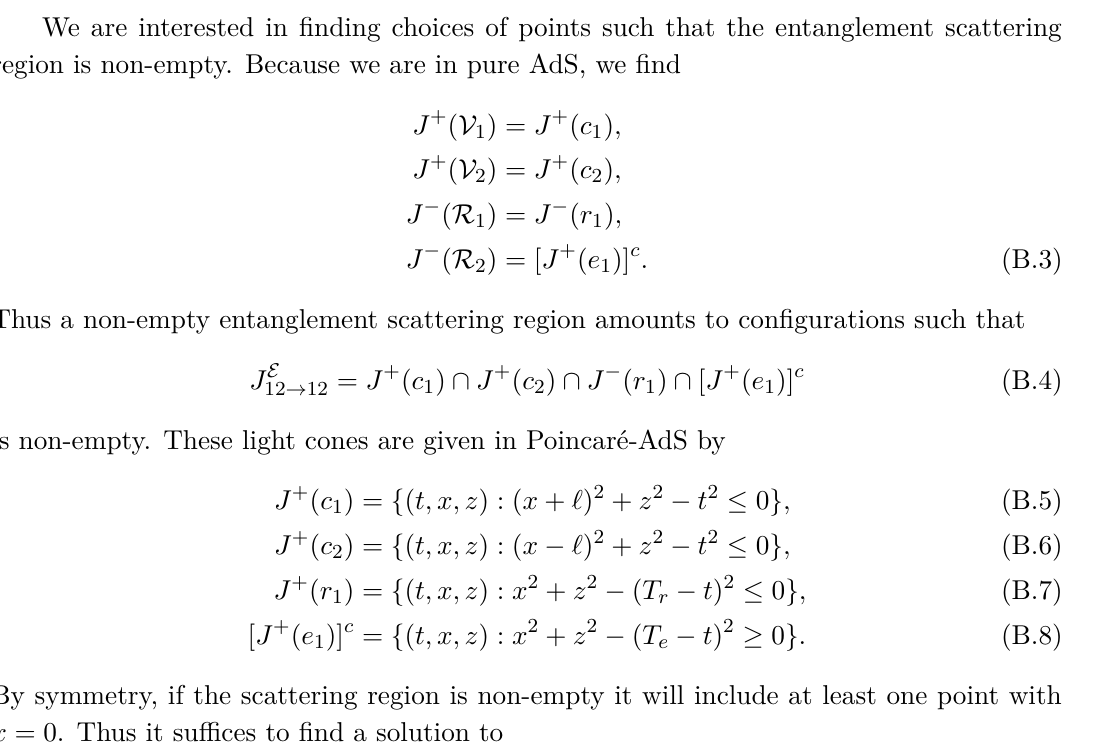
Figure 7. A typical choice of regions AdS which leads to a non-trivial conclusion in the connected wedge theorem 4. The regions are conveniently specified by choosing the four points c